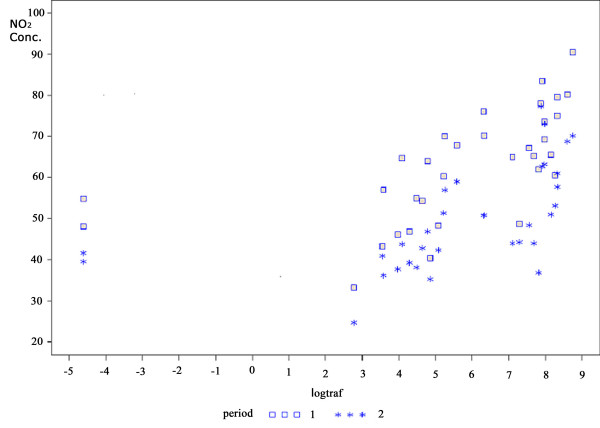
NO2 concentration according to traffic counting (log). r = 0.65 p < 0.001 for periods 1 + 2. r = 0.75 p < 0.001 for period 1. r = 0.71 p < 0.001 for period 2.